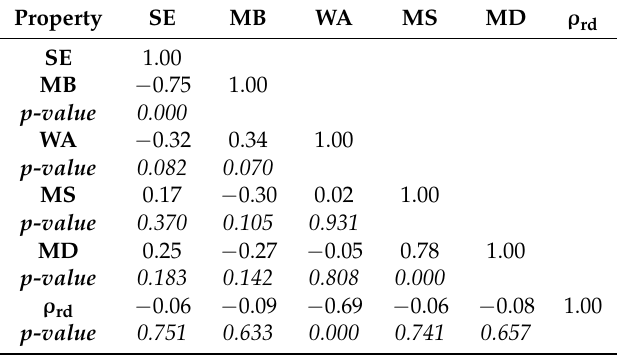
Table 4. Pearson correlations and p -values for the various fine aggregate